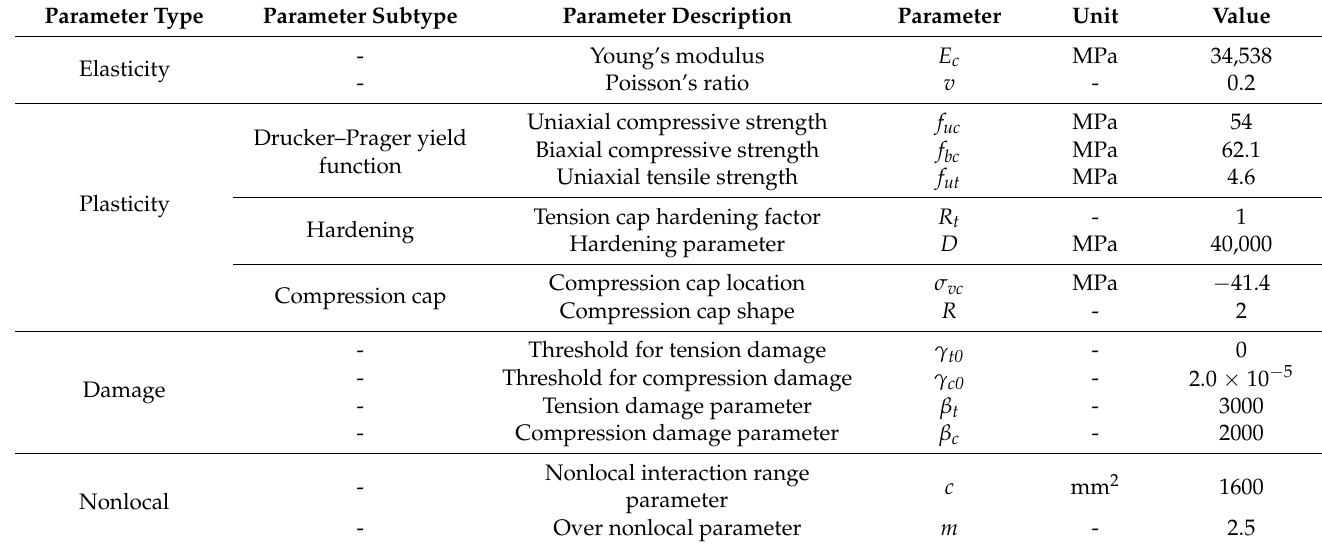
Table 1. Coupled damage–plasticity microplane model